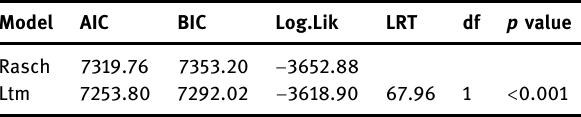
Table 4: Comparison of Ltm and Rasch model fi tting indices in LTA